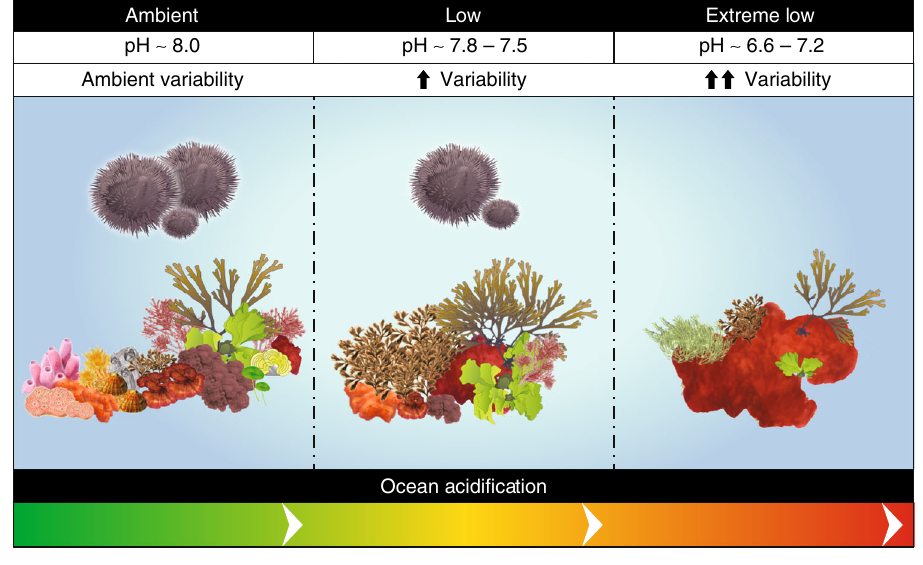
Fig. 4 Taxonomic and functional biodiversity loss along the pH gradient. The ambient pH zone is characterized by a mosaic of strategies, from ‘ faster ’ to ‘ slower ’ life histories, from encrusting to massive and erect forms, including a variety of sizes, both photosynthetic autotrophy and heterotrophy (including fi lter feeders and grazers/herbivores), and the presence of calcareous skeletons. The low pH zone is mainly characterized by fl eshy morphologies, seasonal population dynamics, fast growth and is mainly composed of non-calcareous organisms, where photosynthetic autotrophy is the major energetic resource. The conditions in low pH zones are used to represent atmospheric carbon dioxide concentration values under future climatic conditions with a decrease in surface pH from − 0.14 to − 0.4 pH units under IPCC RCP2.6 and RCP8.5 by 2100 relative to 1870. The extreme low pH zone is dominated by encrusting- fl eshy forms, ‘ fast' growth, non-calcareous organisms and photosynthetic autotrophy as the only energetic resource. The encrusting red form is Hildenbrandia crouaniorum , a non-calcareous, perennial red algae. This extreme low pH zone is used to represent more extreme scenarios based on high CO 2 emissions or the more distant future by 2500. See Table 1 for names of selected species supporting ecological